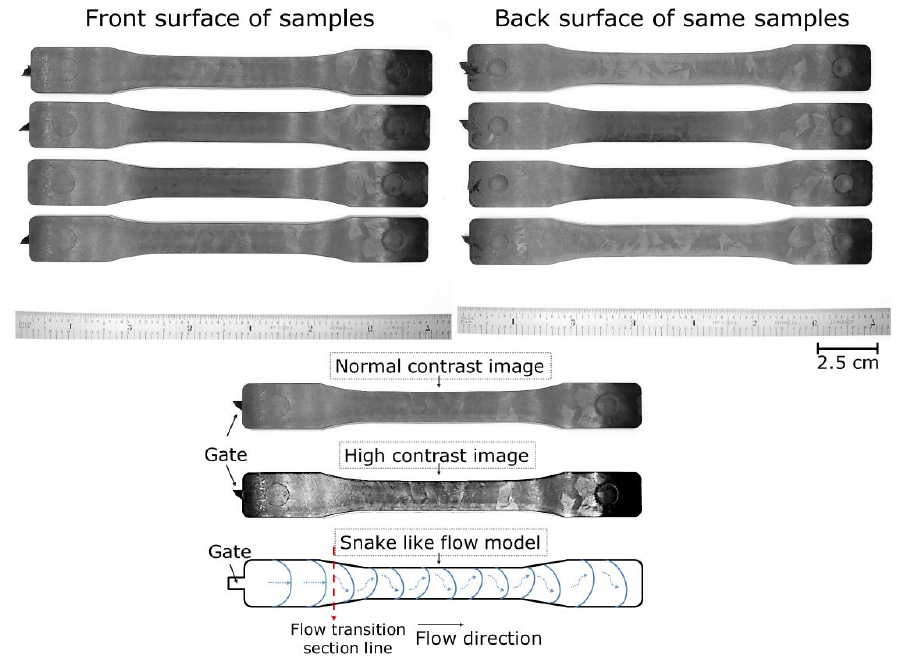
Figure 6. ( Top ) Front and back surfaces of four randomly selected solid samples. ( Bottom ) The speculated melt flow and transition model responsible for the irregular tiger-stripes pattern.